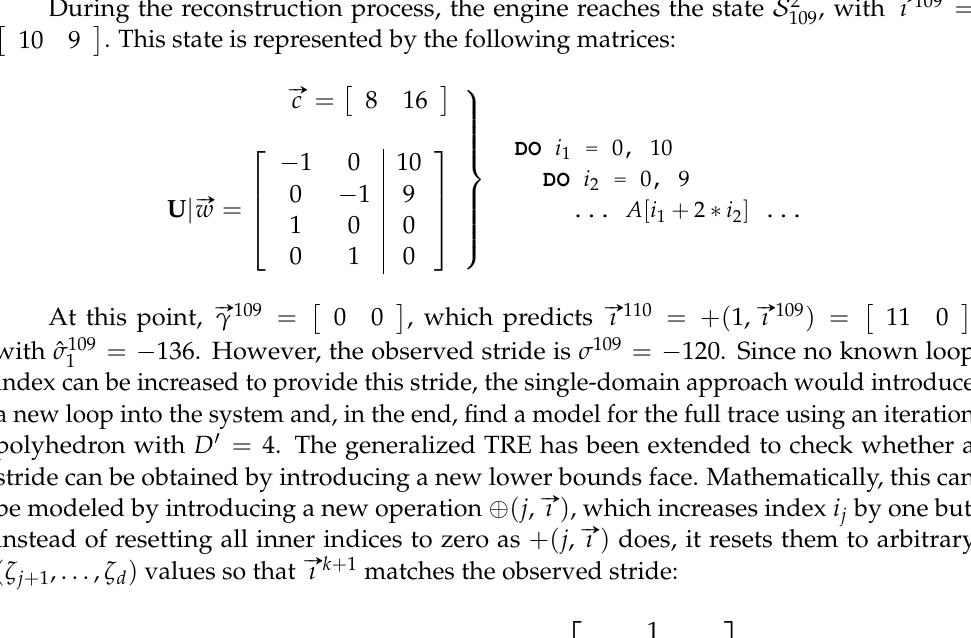
(cid:104) (cid:105) , when it becomes 11 1